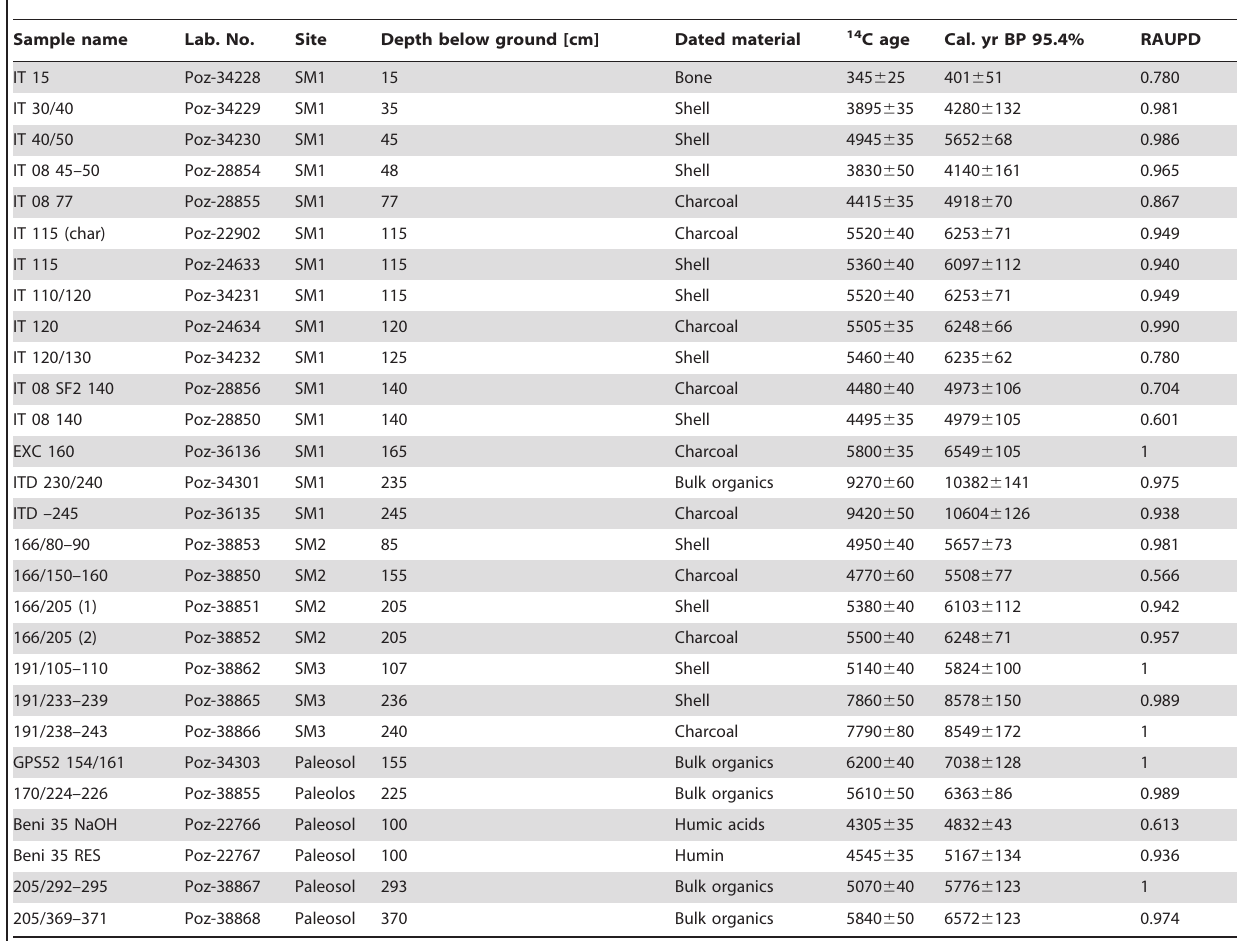
Table 1. List of radiocarbon ages for sites SM1, SM2, SM3 and paleosol.